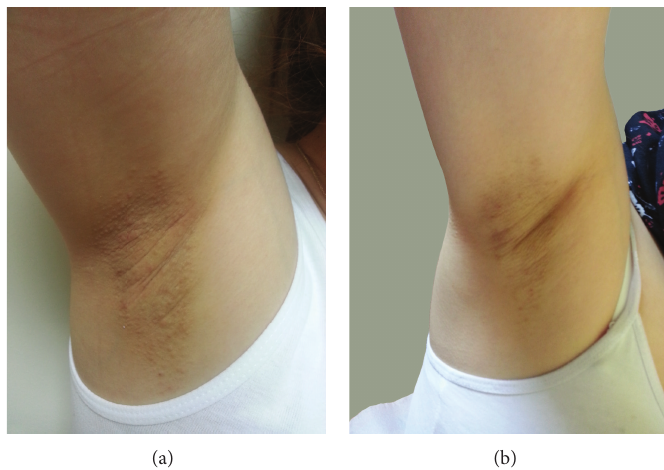
Figure 1: (a) Before treatment and (b) improvement of lesions after 3 months of topical tacrolimus.